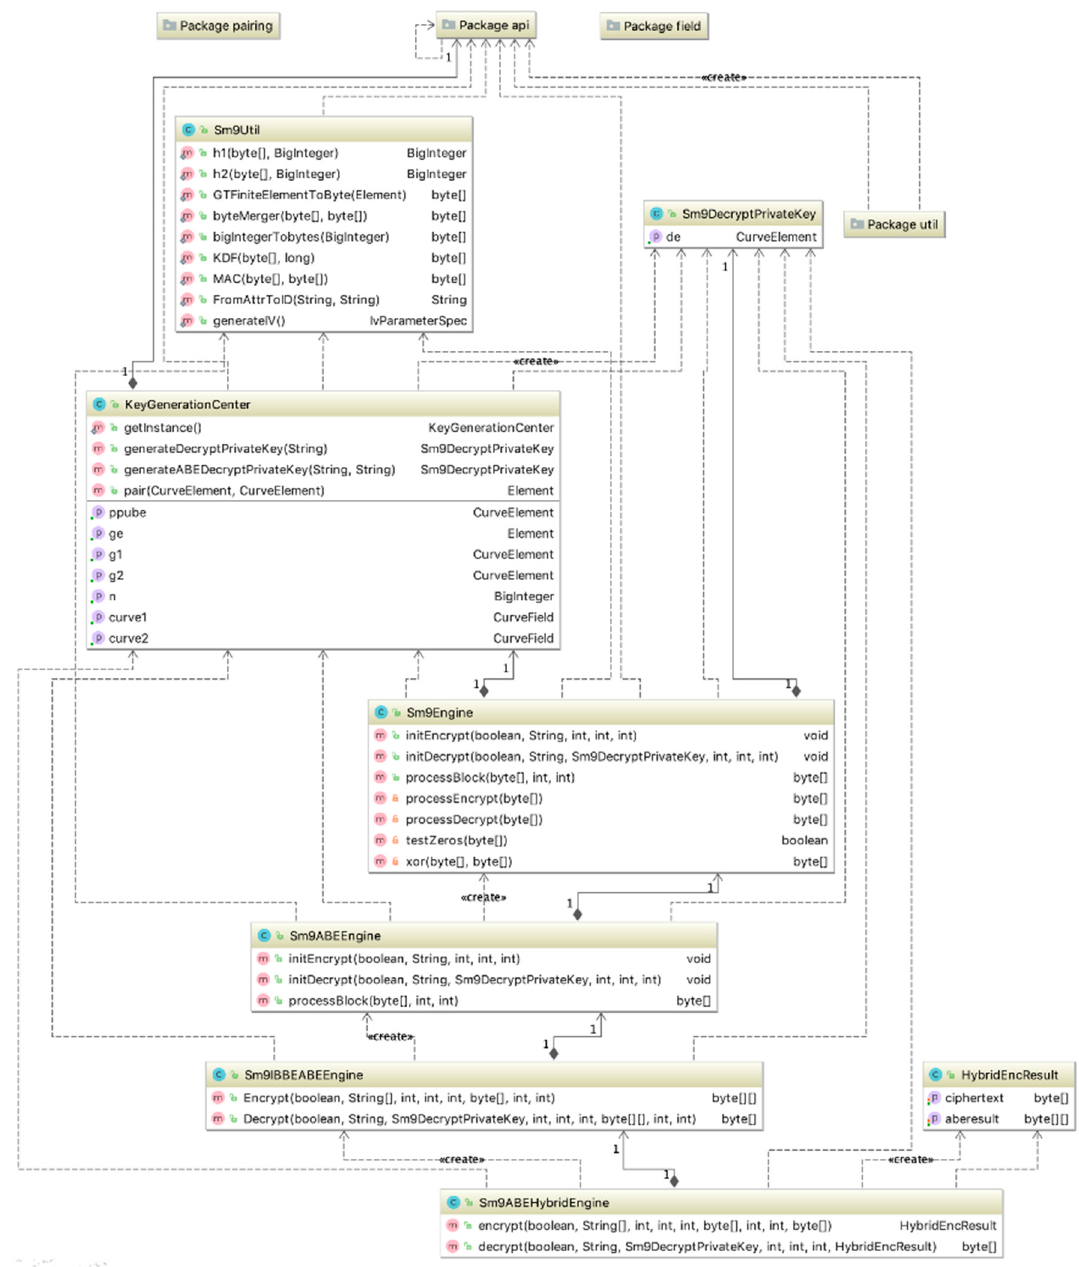
Figure 1. The structure of attribute-based encryption (ABE) and identity-based encryption (IBE) Java implementation.